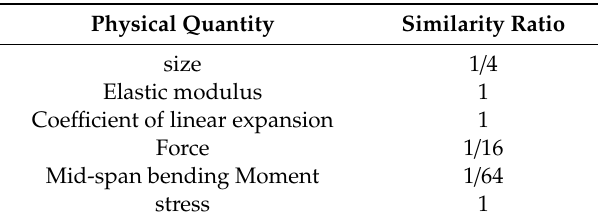
Table 1. Similarity ratio of specimen. Table 1. similarity ratio of specimen.